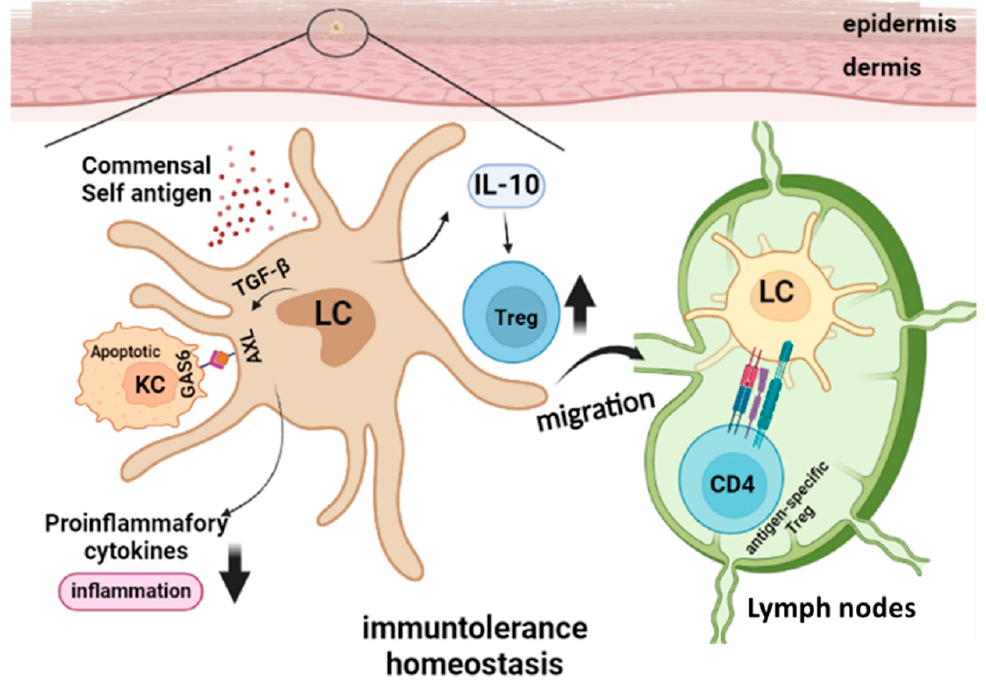
Figure 1. Langerhans Cells in Steady State Skin Immune Homeostasis. In homeostatic conditions, LC constantly migrate to draining Lymph nodes and present self or commensal antigens and drive the development of Treg, while skin local Treg amplification can also be induced by IL-10 produced by LC. Transforming growth factor- β 1 (TGF- β 1)-induced LC differentiation is accompanied by Axl upregulation, which enhances the phagocytosis of Axl ligand GAS6-expressing apoptotic KC and the inhibition of inflammatory cytokine production.